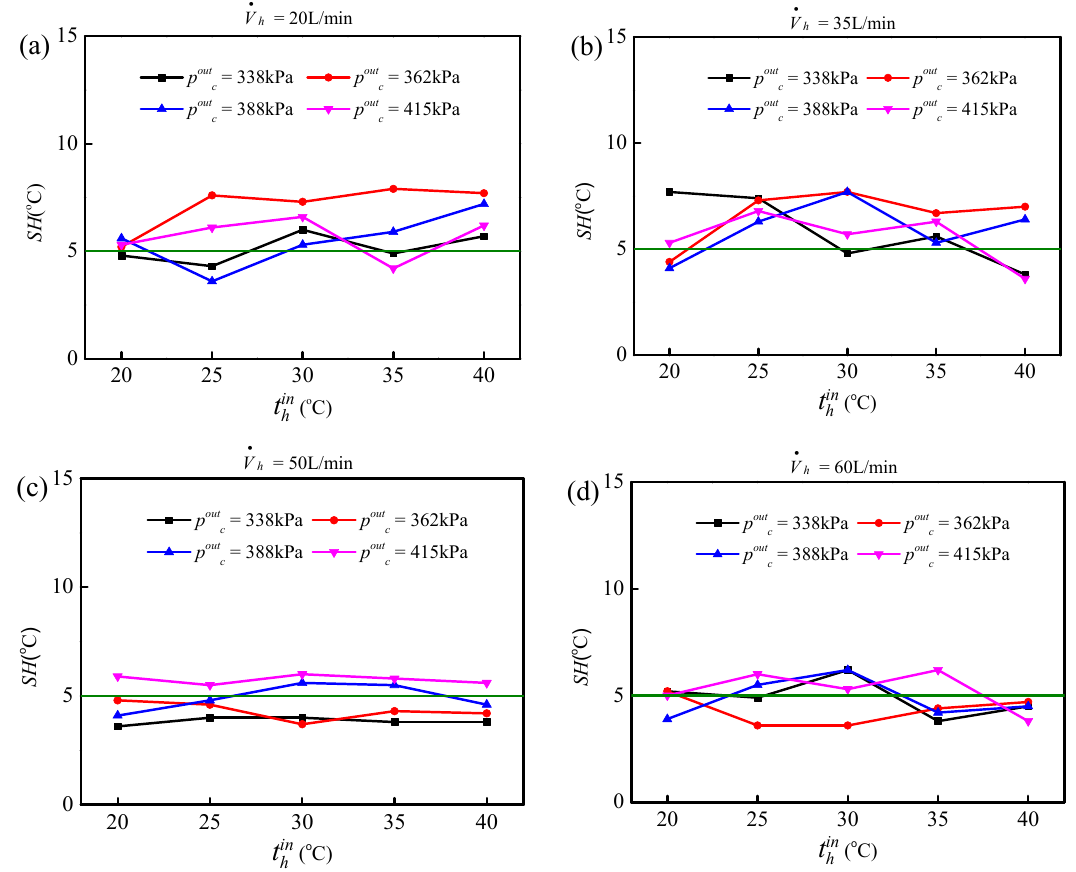
Figure 10. Relationship of SH for given 𝑡 (cid:3035)(cid:3036)(cid:3041) and 𝑝 (cid:3030)(cid:3042)(cid:3048)(cid:3047) .